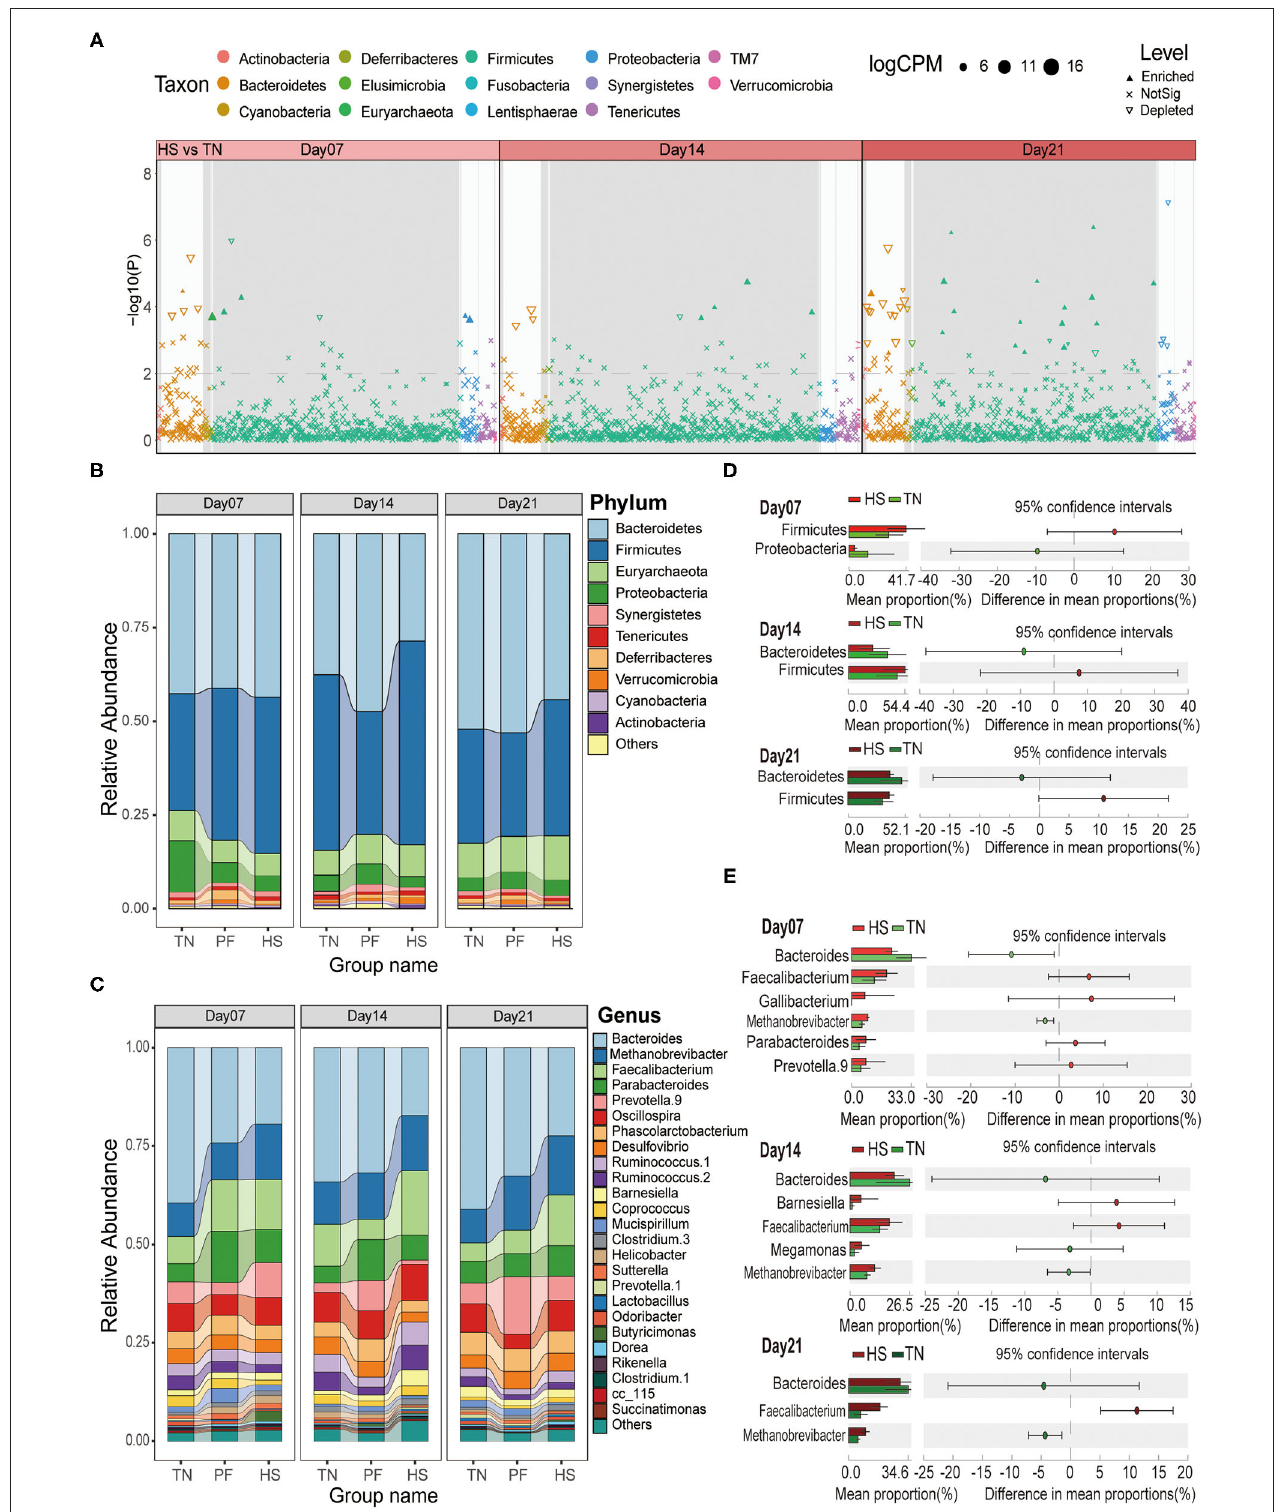
FIGURE 3 | Effects of chronic heat exposure on cecal microbial composition at different taxonomic levels in growing hens. (A) The Manhattan plots show enrichment and depletion of microbial OTUs between HS and TN groups during the experimental period (on Days 7, 14, and 21). The dashed line represents the significant